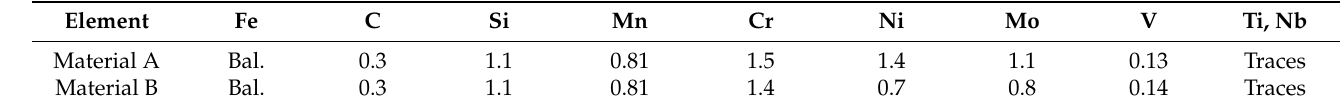
Table 1. Chemical composition of studied steels, values in